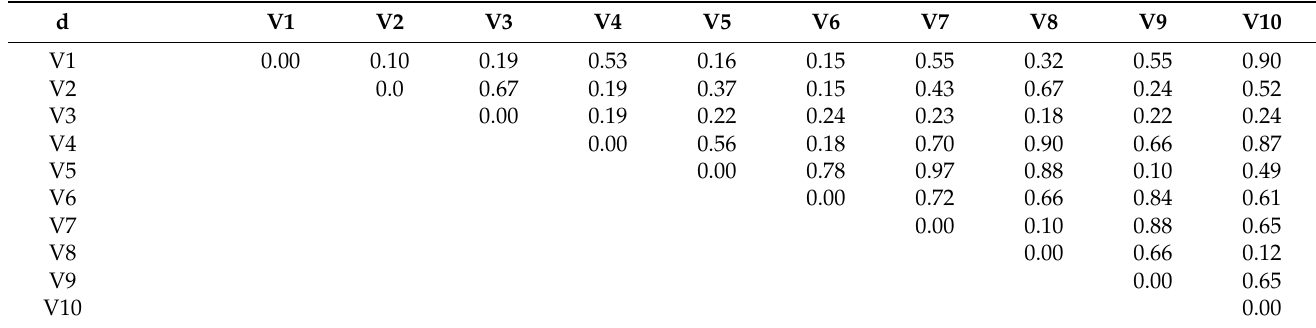
Table 3. Correlation degree of ten variables.